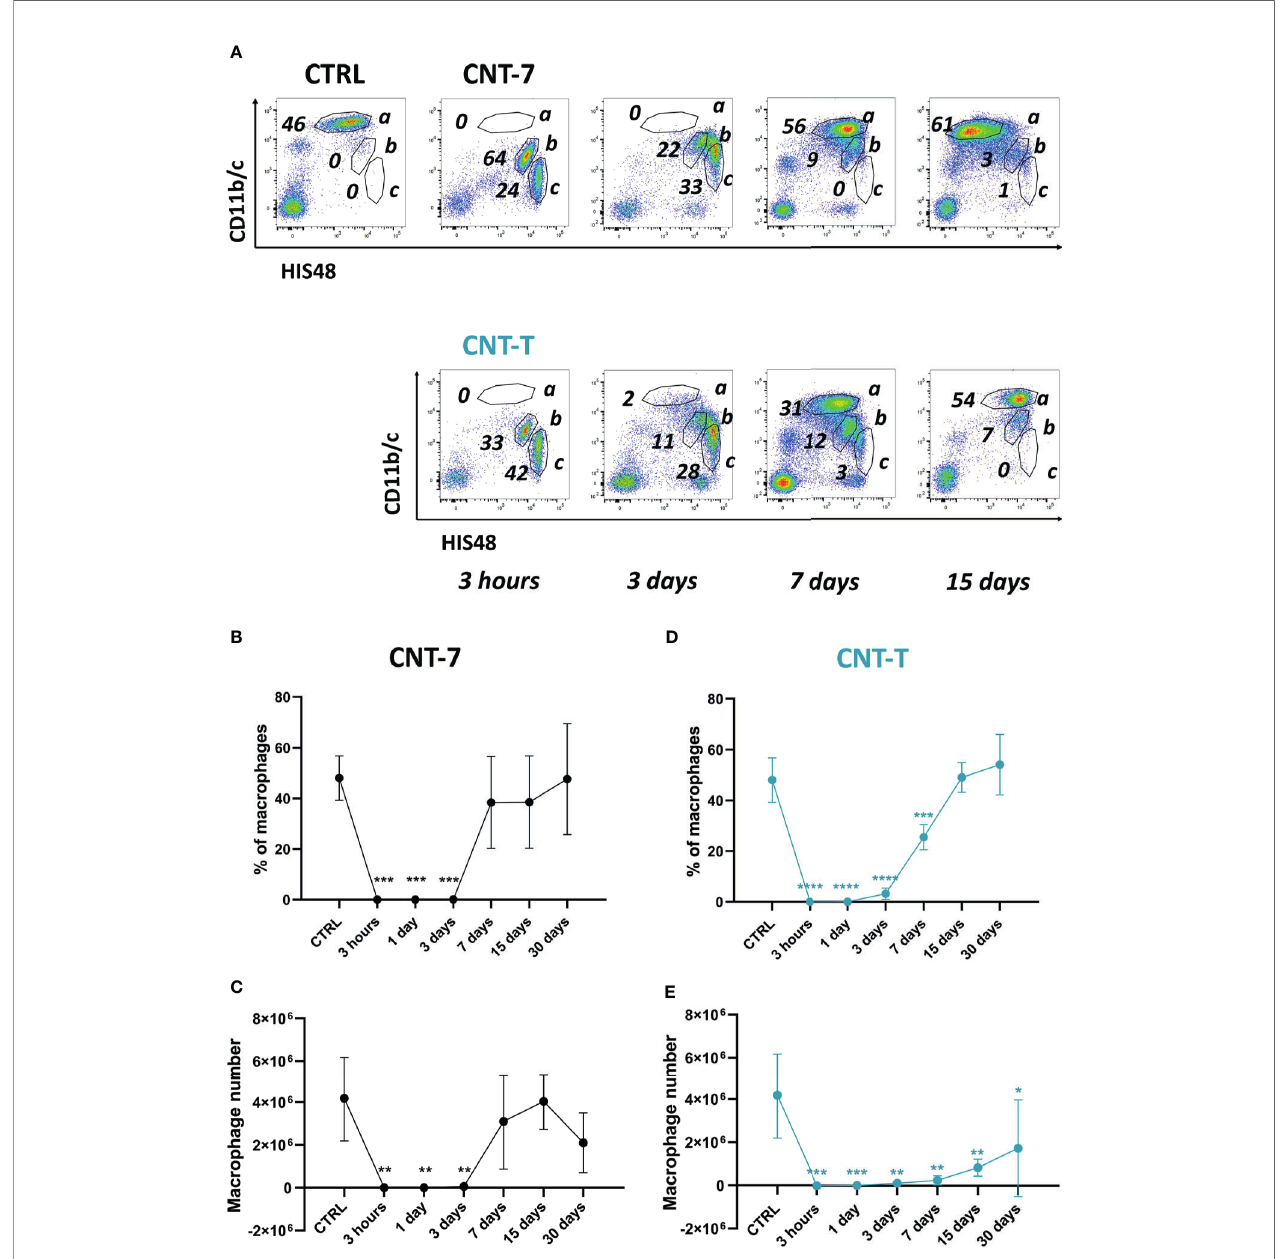
FIGURE 1 | Disappearance reaction and repopulation of peritoneal macrophages after exposure to mesotheliomagenic CNT-7 and non-mesotheliomagenic CNT-T. (A) Flow cytometry dot plots (CD11b/c, His48) of peritoneal cells (a = macrophages, b = neutrophils, c = monocytes) of CTRL (untreated rats sacri fi ced at 3 hours) or CNT-treated Wistar rats (2 mg, I.P.) (3 hours, 3, 7, 15 and 30 days). Proportion (B, D) and total number (C, E) of peritoneal macrophages in response to CNT-7 and CNT-T (day 0-30). Each point represents the mean of 4 samples ± SD. The results were statistically analysed using one-way ANOVA test followed by Dunnett ’ s test. (*) p = 0.0332, (**) p = 0.0021, (***) p = 0.0002, (****) p < 0.0001 indicates a statistically signi fi cant difference with